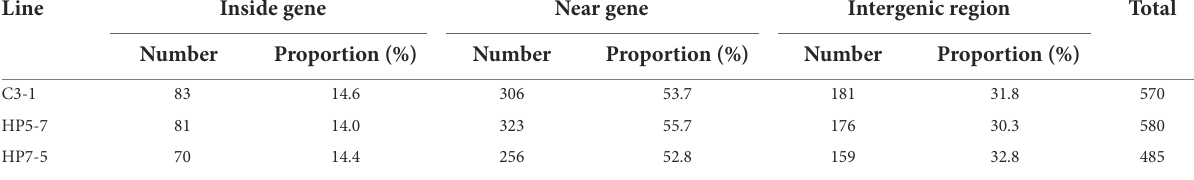
TABLE 2 Distribution of mPing insertion sites in the rice genome.